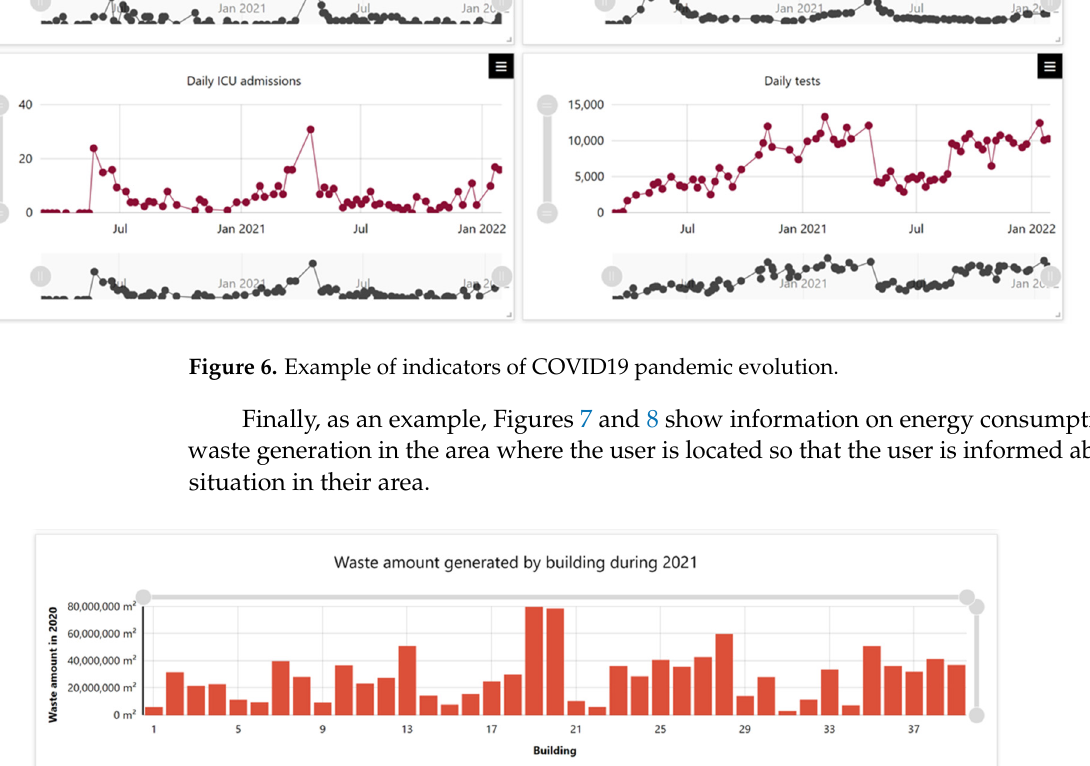
Figure 8. Comparison of responsible consumption based on waste generated in a city between 2020 and 2021.